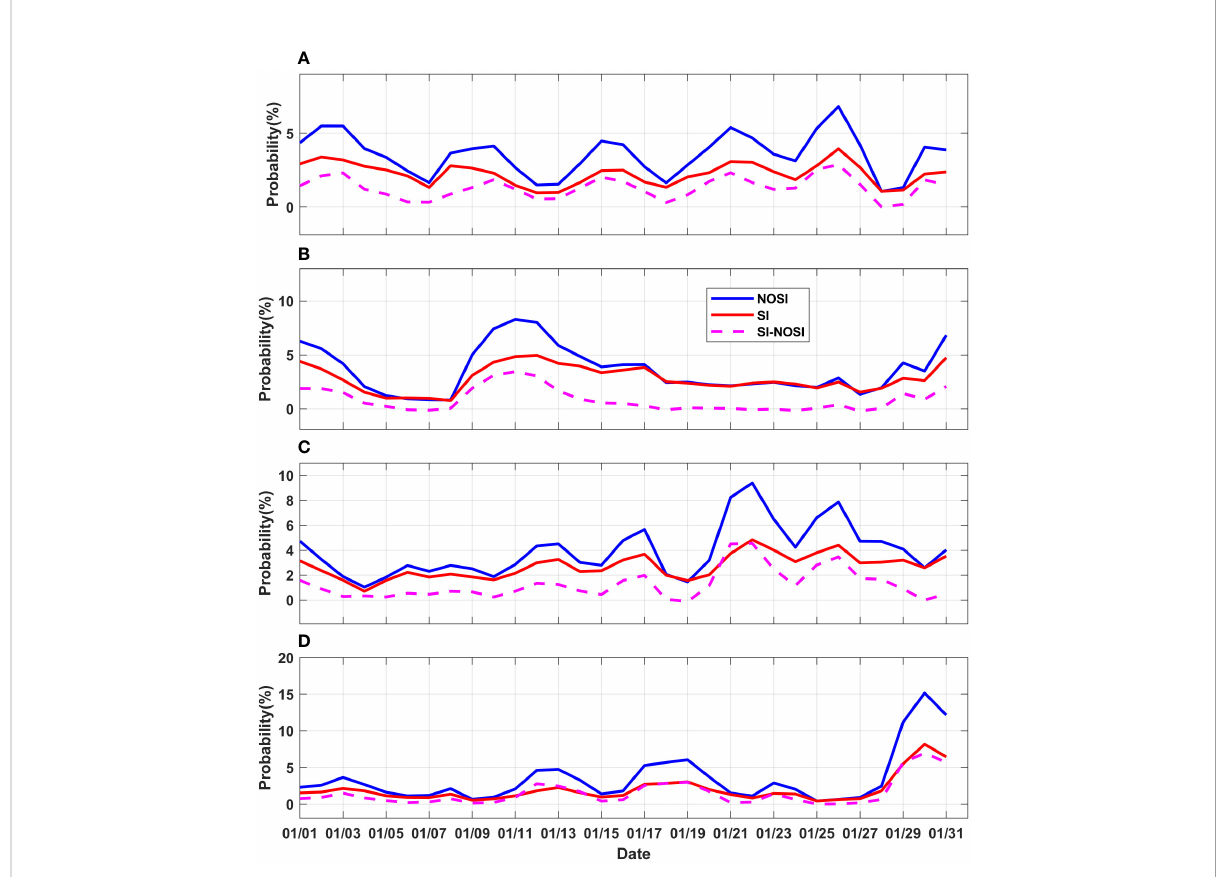
FIGURE 14 The time series of negative PV probability (blue and red line for R1_NOSI and R1_SI, respectively) and its difference (SI-NOSI, magenta line) in the upper 5m of two cases in January (A) 2017, (B) 2018, (C) 2019, (D) 2020. PV, potential